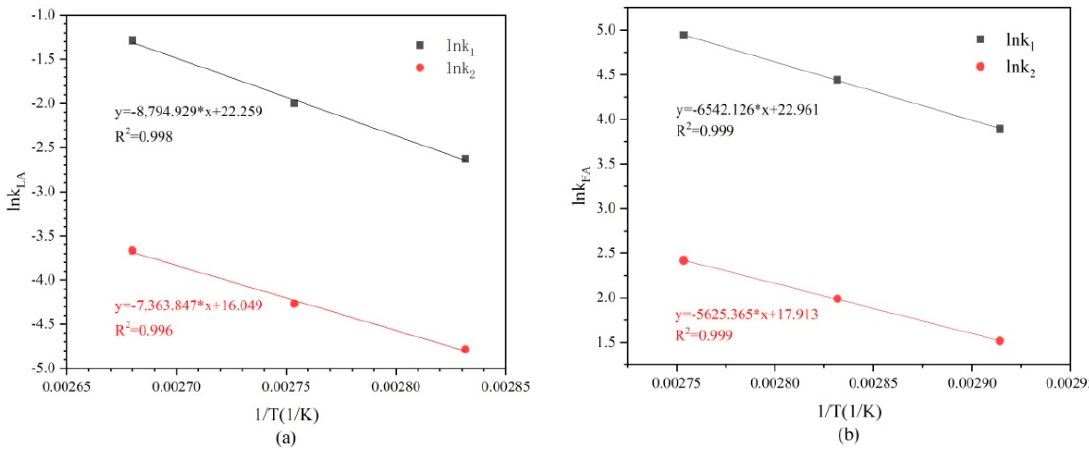
Figure 5. Pre-exponential factor equations of ( a ) LA and ( b ) FA. The kinetic parameters fitted to the experimental data are summarized in Table 1. Table 1. Pre-exponential factors k i,0 and activation energy E a,i .